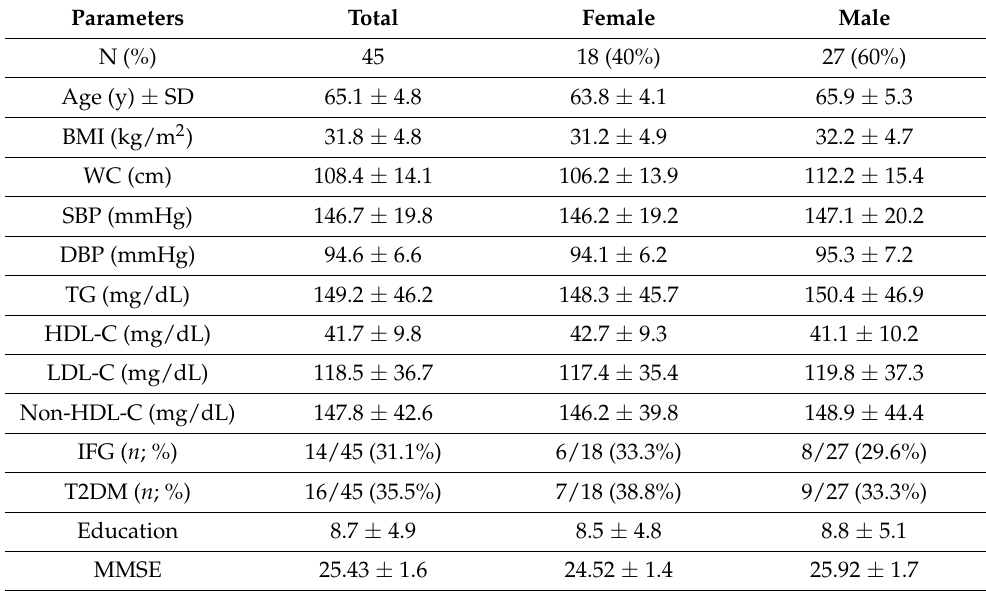
Table 2. The characteristics of the study group.